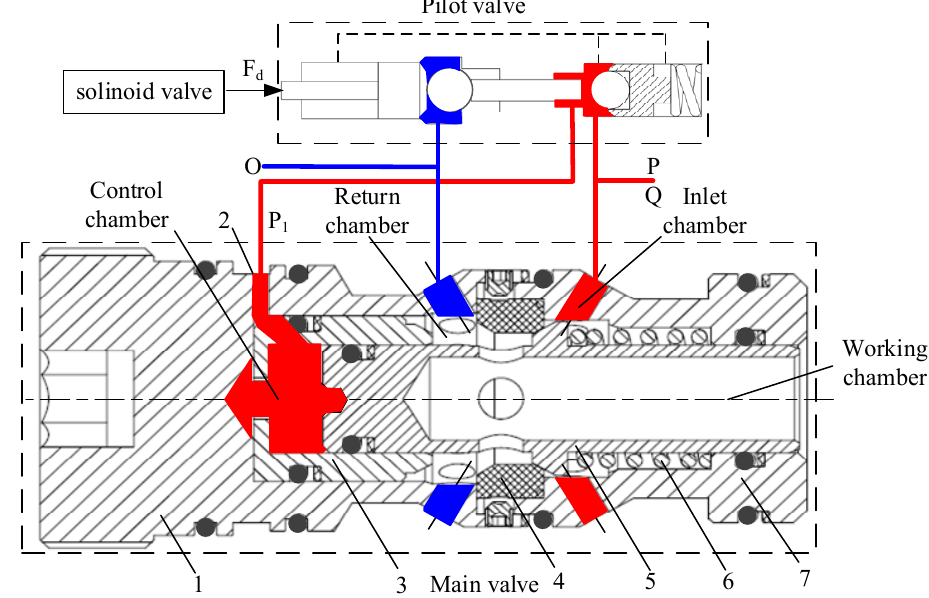
Figure 6. Principle working diagram of a directional valve for hydraulic support. 1. Inlet valve sleeve; 2. Spring; 3. Inlet valve spool; 4. Valve seat; 5. Return valve spool; 6. Fixed orifice; 7. Return valve sleeve.